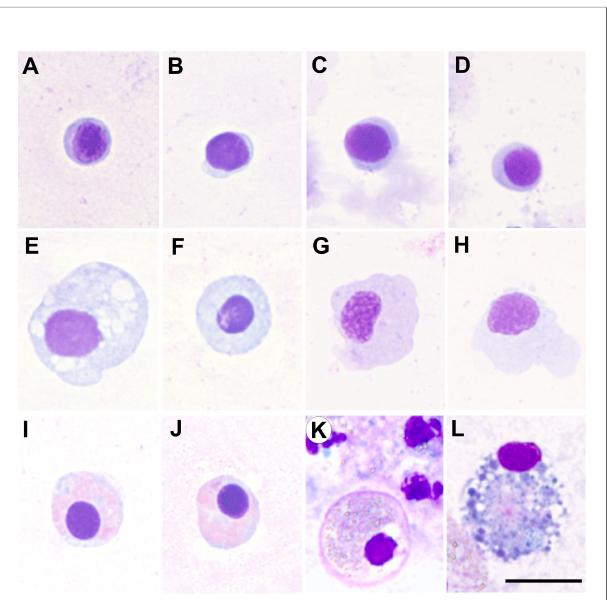
FIGURE 1 | Micrographs of haemocyte types of various bivalve species, all them corresponding to haemolymph samples collected from the adductor muscle, cytocentrifuged onto slides and fi xed and stained with the kit Hemacolor ® (Merck). (A – D) Blast-like cells of Ruditapes decussatus , Ruditapes philippinarum , Aequipecten opercularis and Mimachlamys varia , respectively. (E – H) Hyalinocytes of R. decussatus , R. philippinarum , A. opercularis and M. varia , respectively. (I – K) Eosinophilic granulocytes of R. decussatus , R. philippinarum and Ostrea edulis , respectively. (L) Basophilic granulocyte of O. edulis . Scale bar: 10